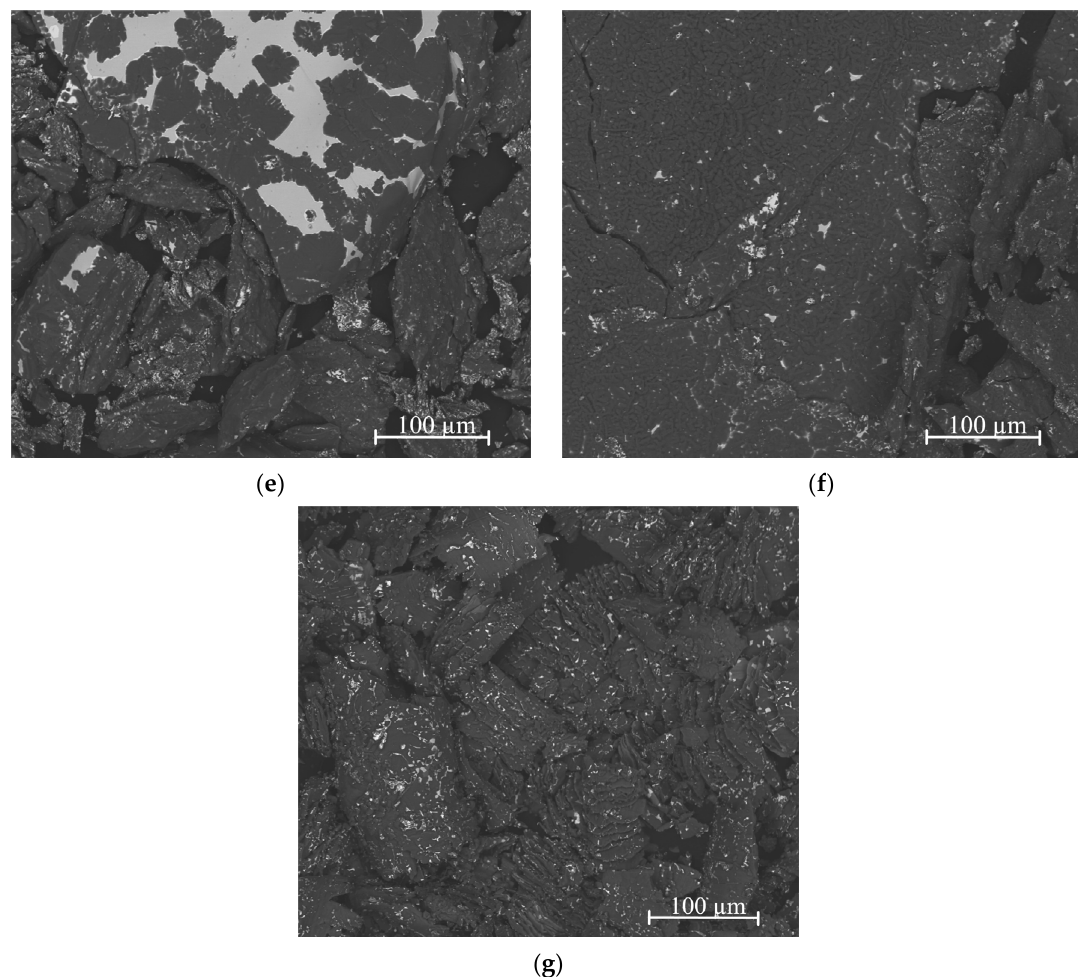
Figure 7. SEM microstructures of Ag-Mg alloys after hydrogenation: ( a ) Alloy 10, ( b ) Alloy 9, ( c ) Alloy 8, ( d ) Alloy 7, ( e ) Alloy 6, ( f ) Alloy 5, and ( g ) Alloy 2.